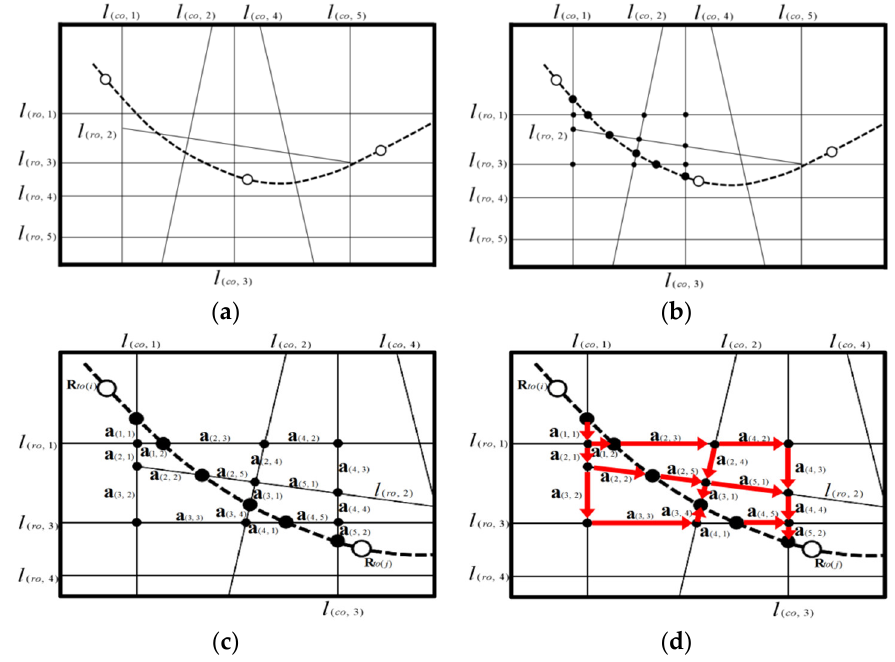
Figure 5. The point set spatial distribution of the tourist attraction approaching vector searching algorithm and the dynamic graph of the searching vectors. ( a ) shows the relationship between the connecting lines and the city roads. ( b ) shows the intersection point set. ( c ) is the abstracted intersection point set’s geospatial distribution. ( d ) shows the searching direction of the approaching vector. Set up the closest approach vector